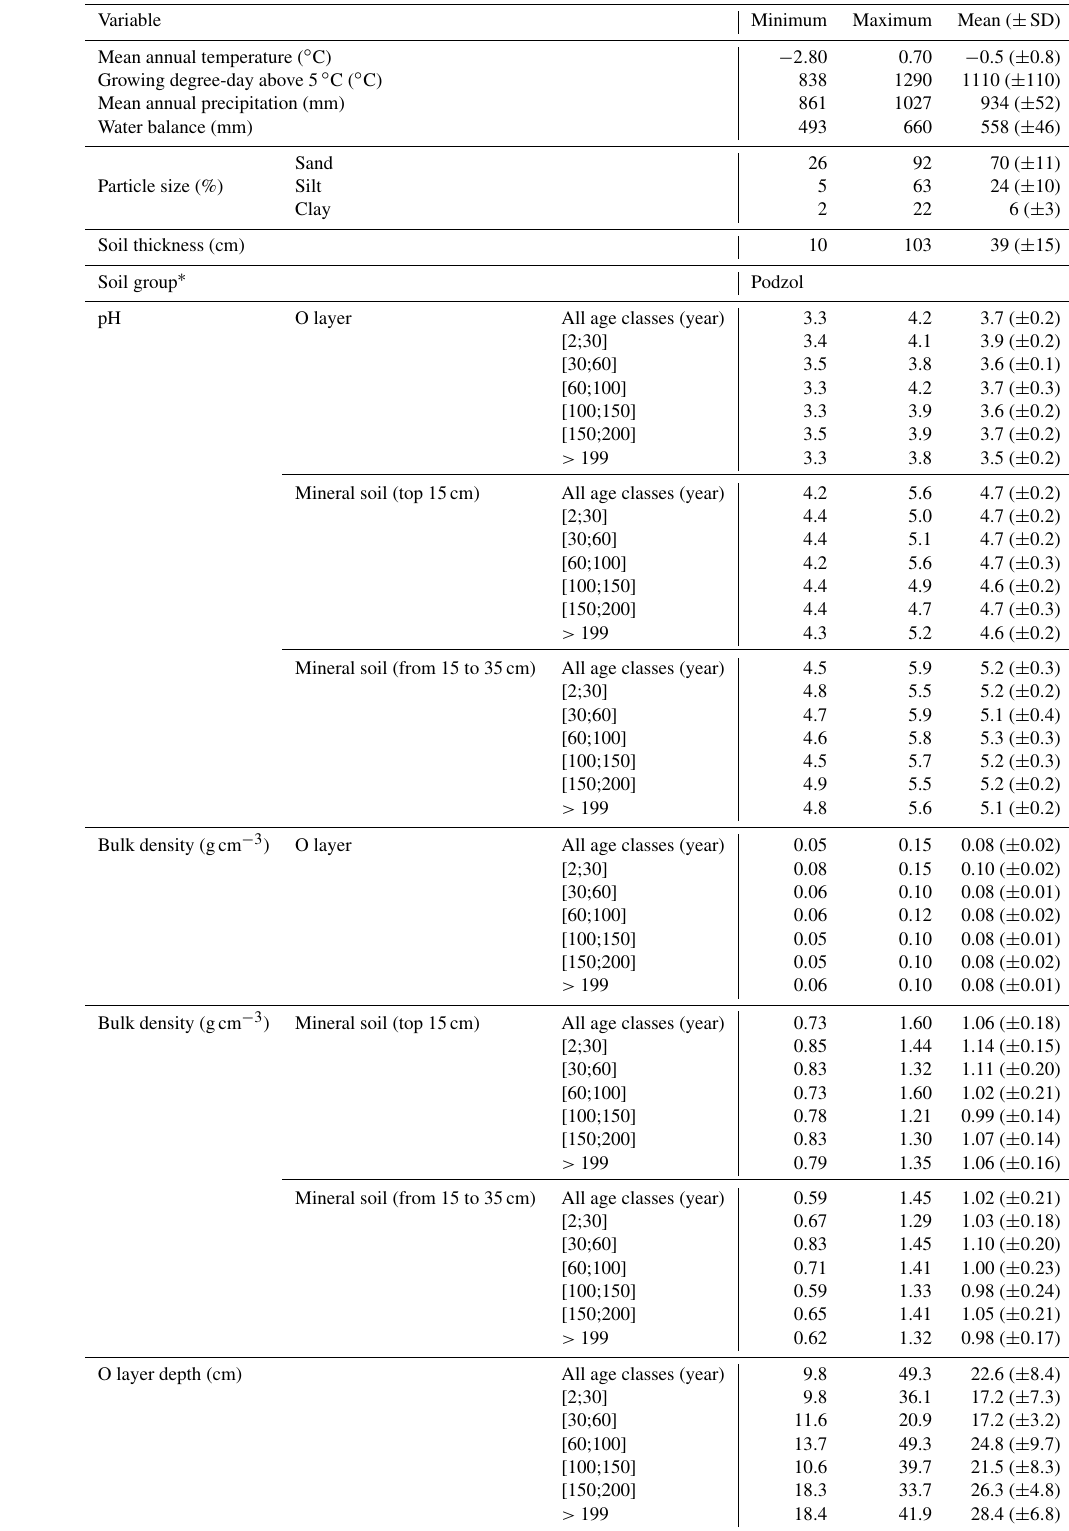
Table 1. General characteristics of the sampling sites.